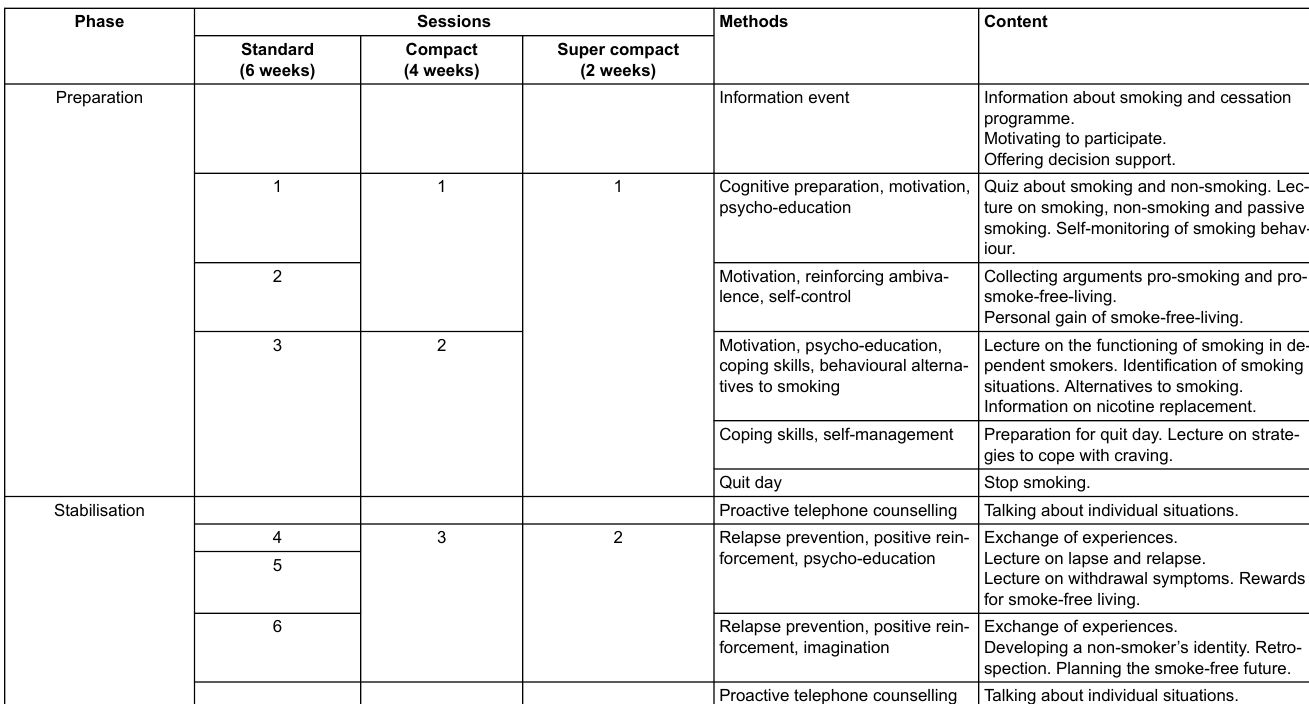
Table 1: Training structure and